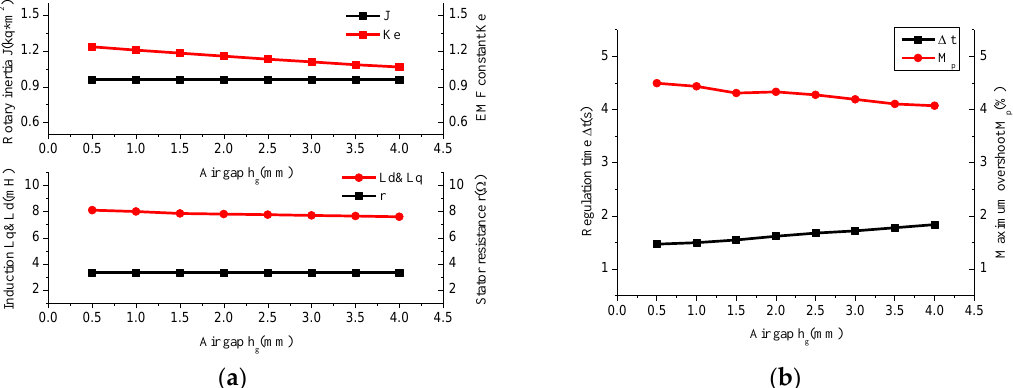
Figure 11. Influence of different air gap length: ( a ) Model variables; ( b ) Dynamic characteristic response.